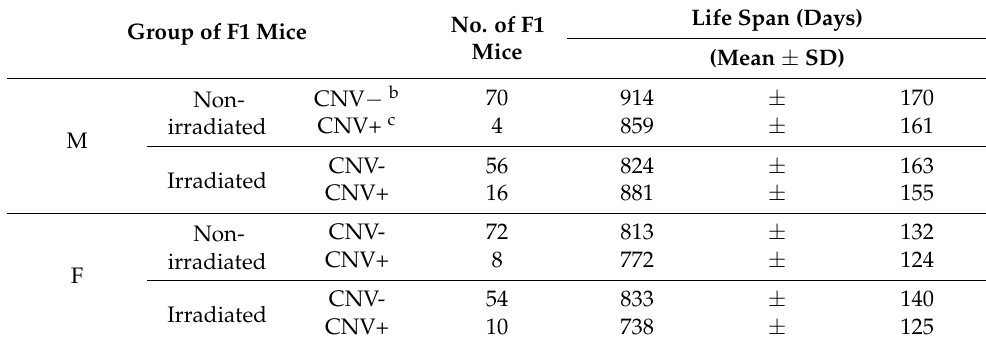
Table 6. Life span of F1 mice a .